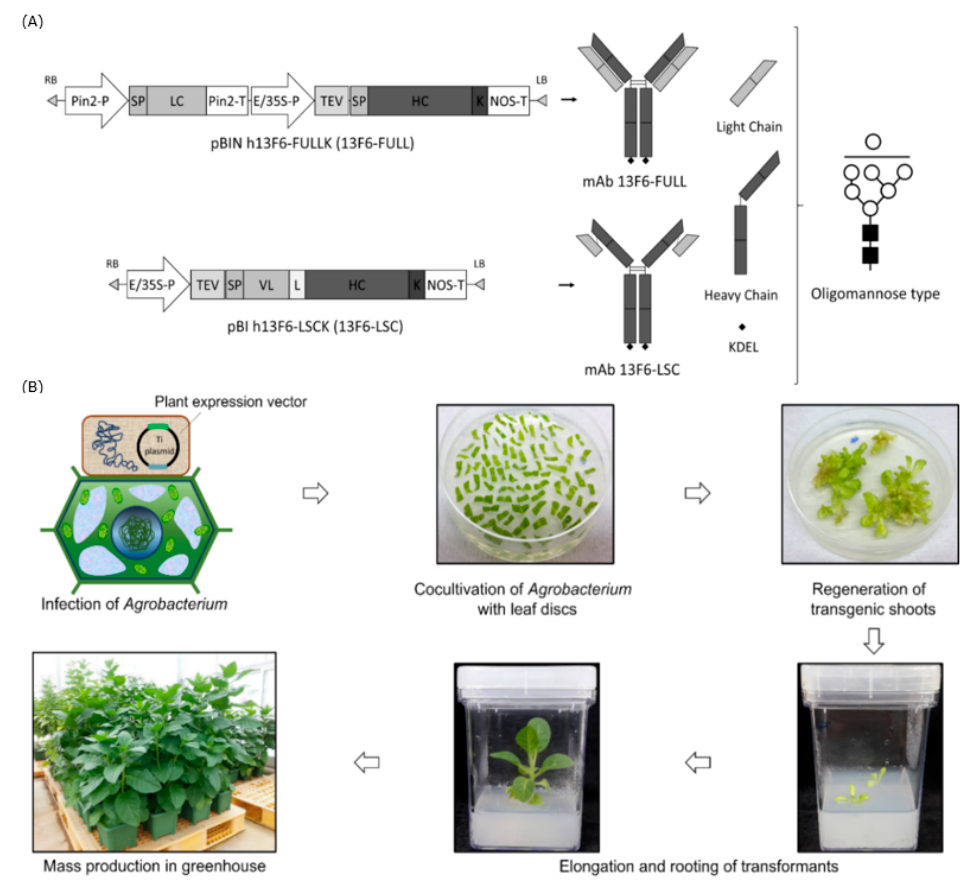
Figure 1. Schematic representation of the plant expression cassette and Agrobacterium-mediated plant transformation for the production of transgenic plants expressing 13F6 antibodies. ( A ) Plant